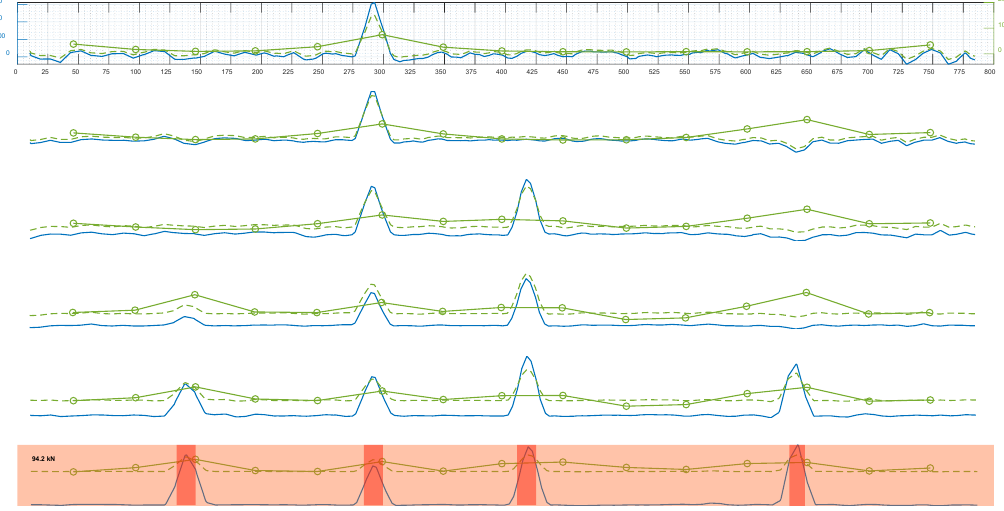
Figure 12. Surface deformation in cracking loads for 2-N100, together with strain in the embedded rebar and that predicted by the proposed equation.